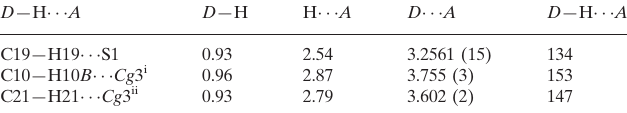
Hydrogen-bond geometry (A˚ , (cid:2) ). Cg 3 is the centroid of the C11–C16